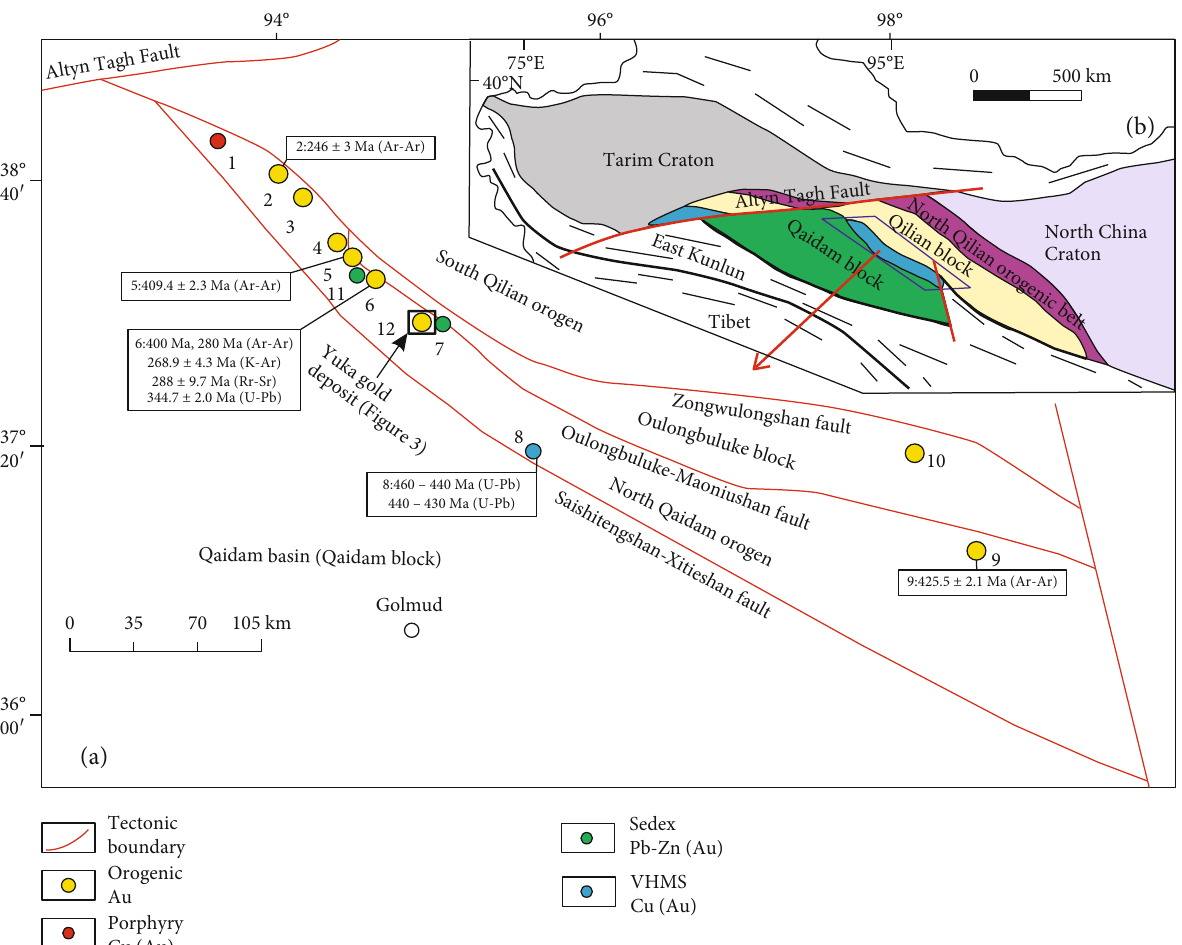
Figure 2: (a) Schematic map showing the major tectonic units in NW China (modi fi ed after Song et al. [40]); (b) simpli fi ed map showing the tectonic framework of the northern margin of the Qaidam basin and spatial location of the Yuka gold deposit. Orogenic gold mineral deposits: 2: Yeluotuoquan; 3: Qianmeiling; 4: Hongliugou; 5: Qinglonggou; 6: Tanjianshan; 9: Saibagou; 10: Qiulute; 12: Yuka. Cu(Au) porphyry mineral deposits: 1: Xiaosaishitengshan. Sedex Pb-Zn(Au): 8: Xitieshan. VHMS Cu(Au): 7: Luliangshan; 11: Qinglongtan (modi fi ed after Zhang et al.